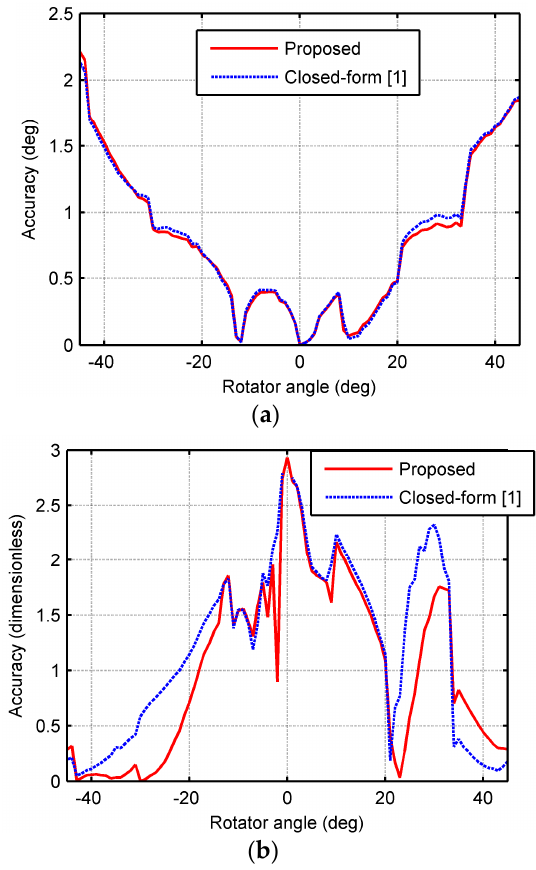
Figure 7. Estimated accuracies comparison of the proposed algorithm and the closed-form algorithm. ( a ) The elevation angle; ( b ) the range.